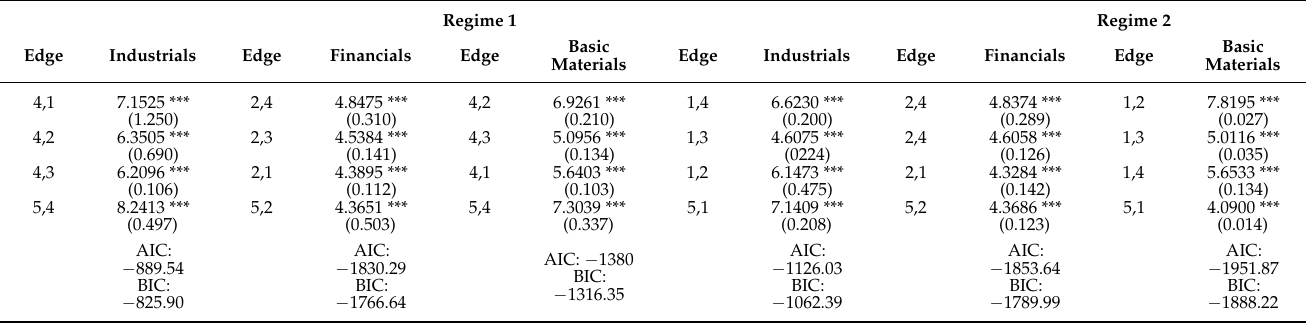
Table 4. Estimates parameters of C-Vine copulas in the sectors of equity